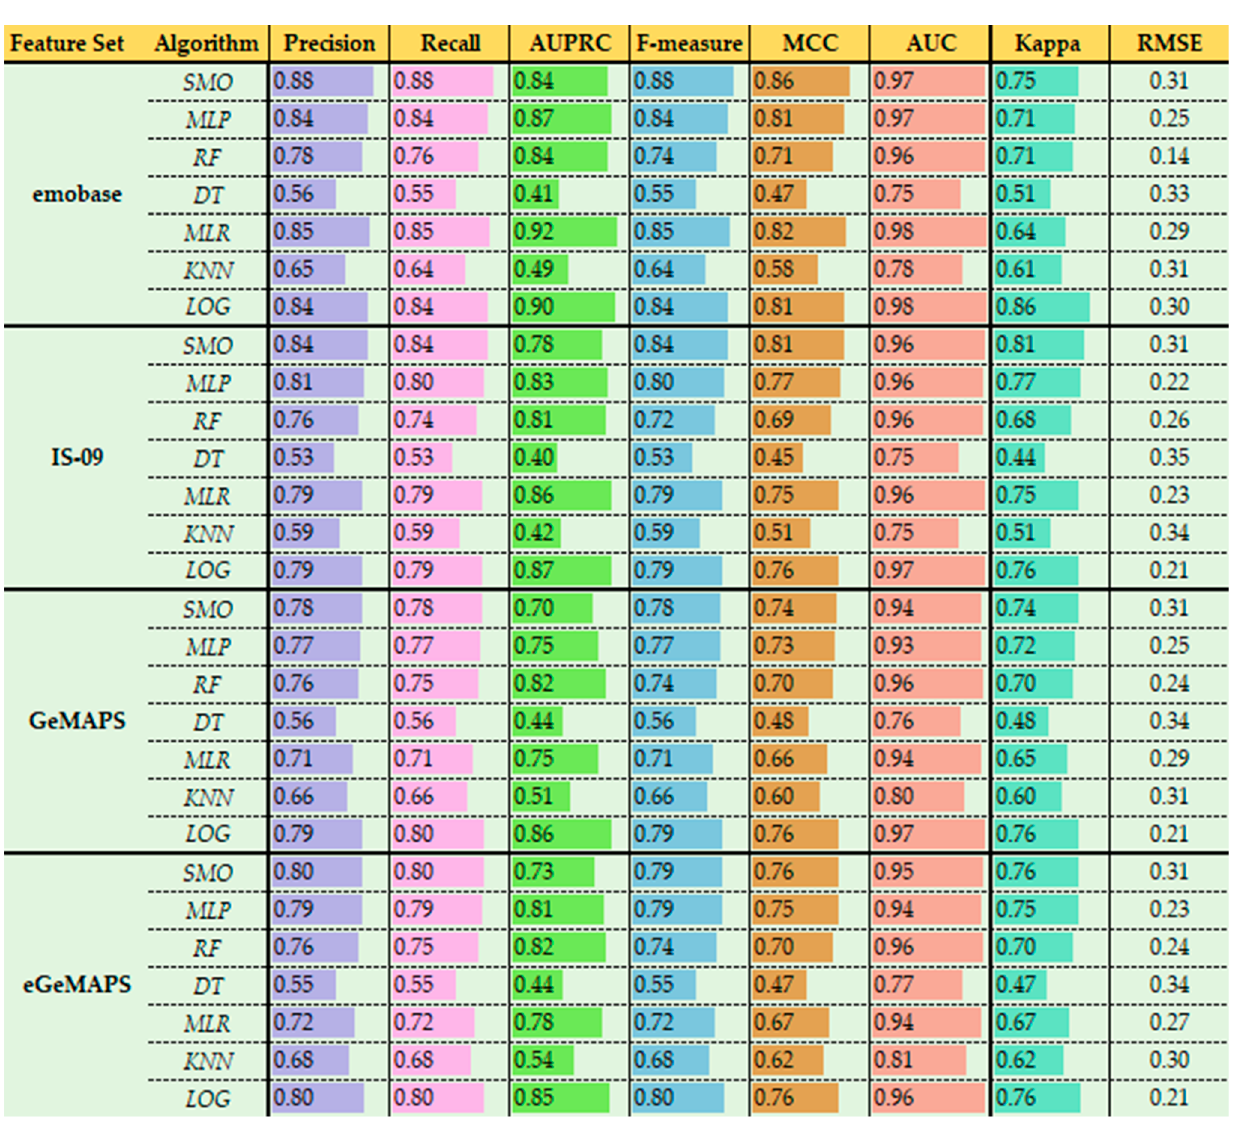
Figure 2. Classification performance measures among feature sets. Precision, Recall, AUPRC and AUC values are weighted averages among number of instances of each class in the database. Data bars represent values between 0 and 1. Length of the data bars are determined by the number in each cell. Table 4. Cross-Validated Paired T-Test Comparison (two-tailed) with the Test Base SMO Classi- fier. *: p < 0.05. **: p ≤ 0.001. Note that positive t-values indicate better performance of the SMO classifier. Classifier and feature set names and abbreviations are written bold.